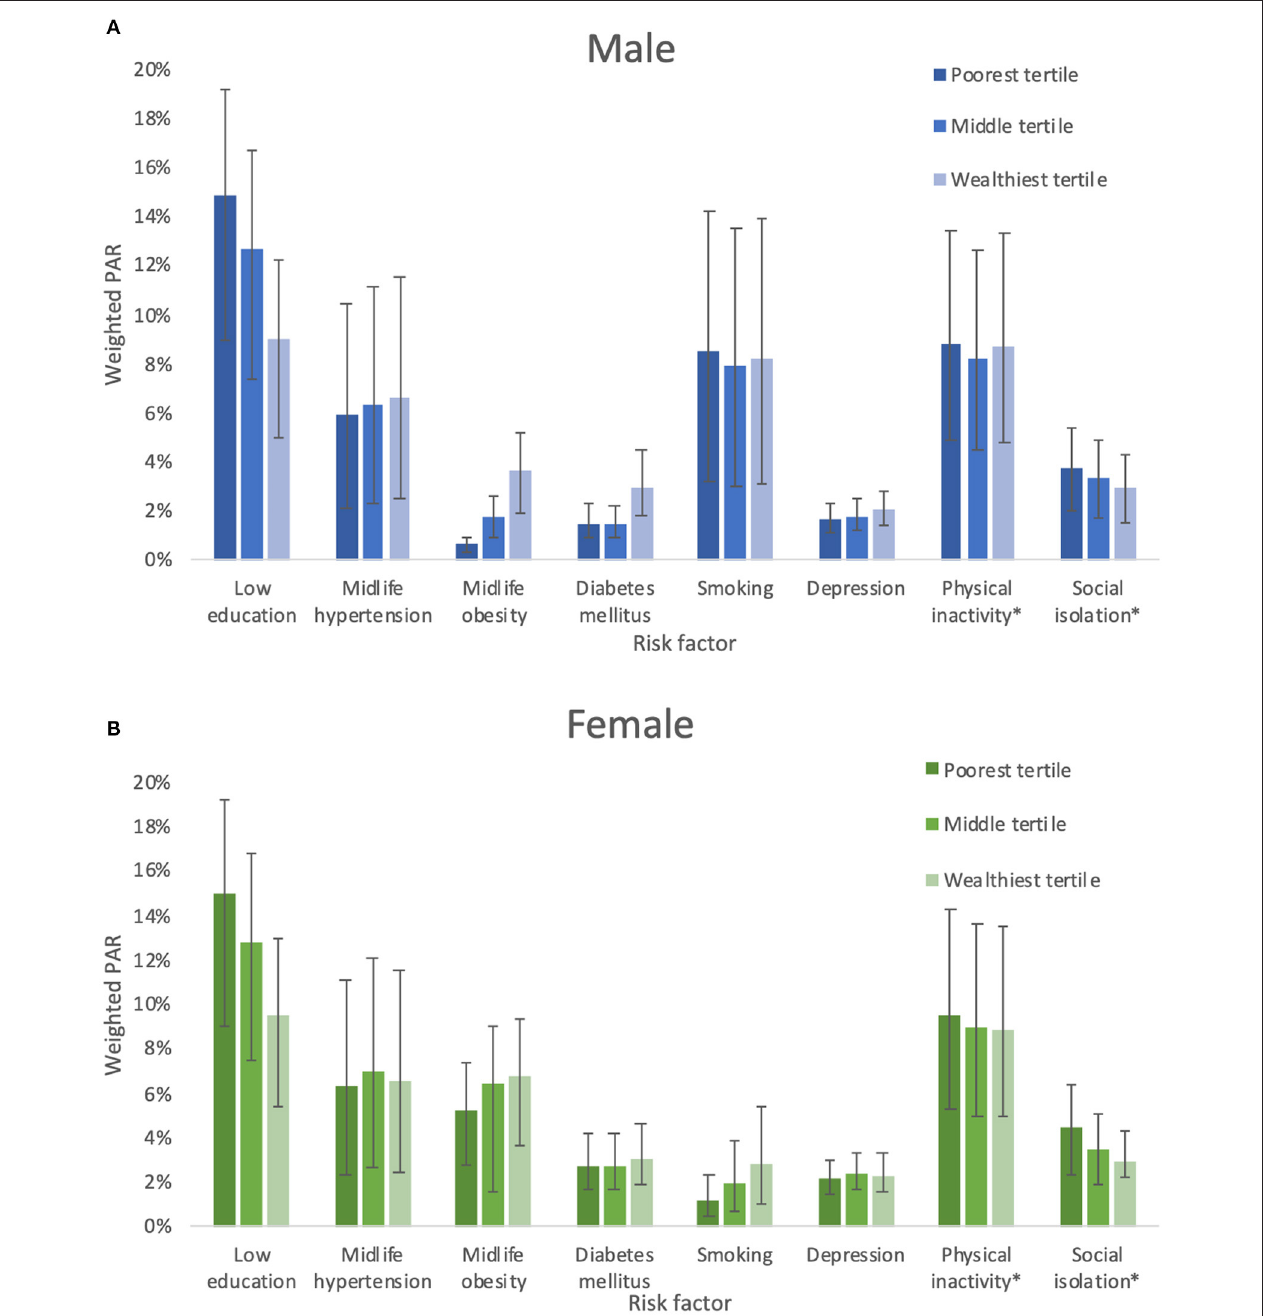
FIGURE 1 | (A) Weighted PAR for dementia risk factors in males. (B) Weighted PAR for dementia risk factors in females. *No significant interaction between sex or wealth and physical acitvity or social isolation.